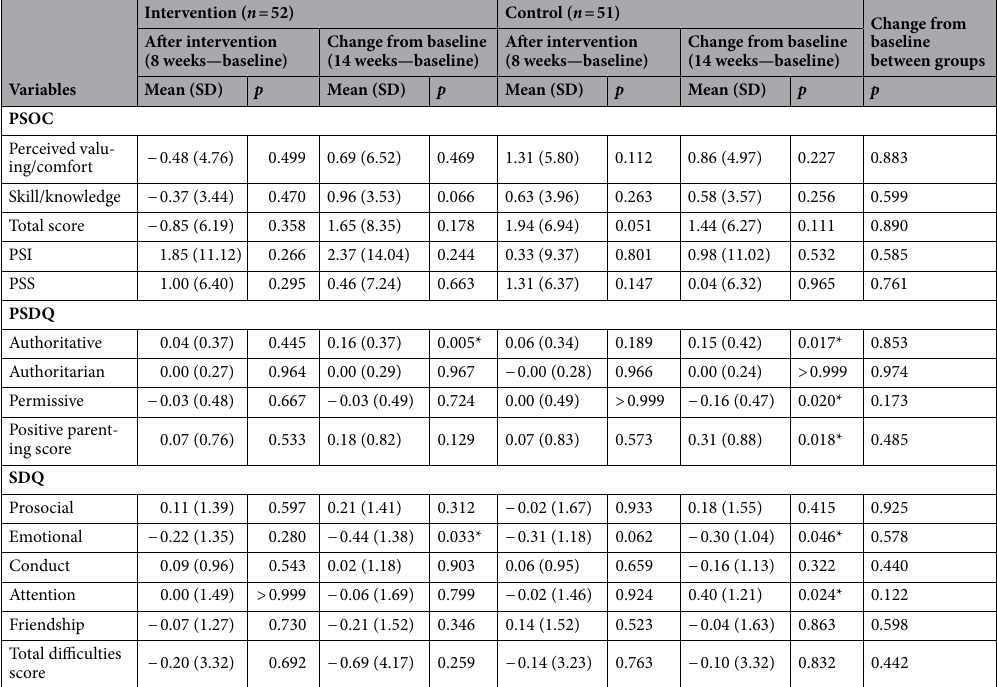
Table 3. Mean differences of parents’ and children’s outcomes at 8 and 14 weeks within and between groups. PSOC Parenting Sense of Competence, PSI Parenting Stress Index, PSS Parental Stress Scale, PSDQ Parenting Styles and Dimensions Questionnaire, SDQ Strengths and Difficulties Questionnaire. * p < 0.05.